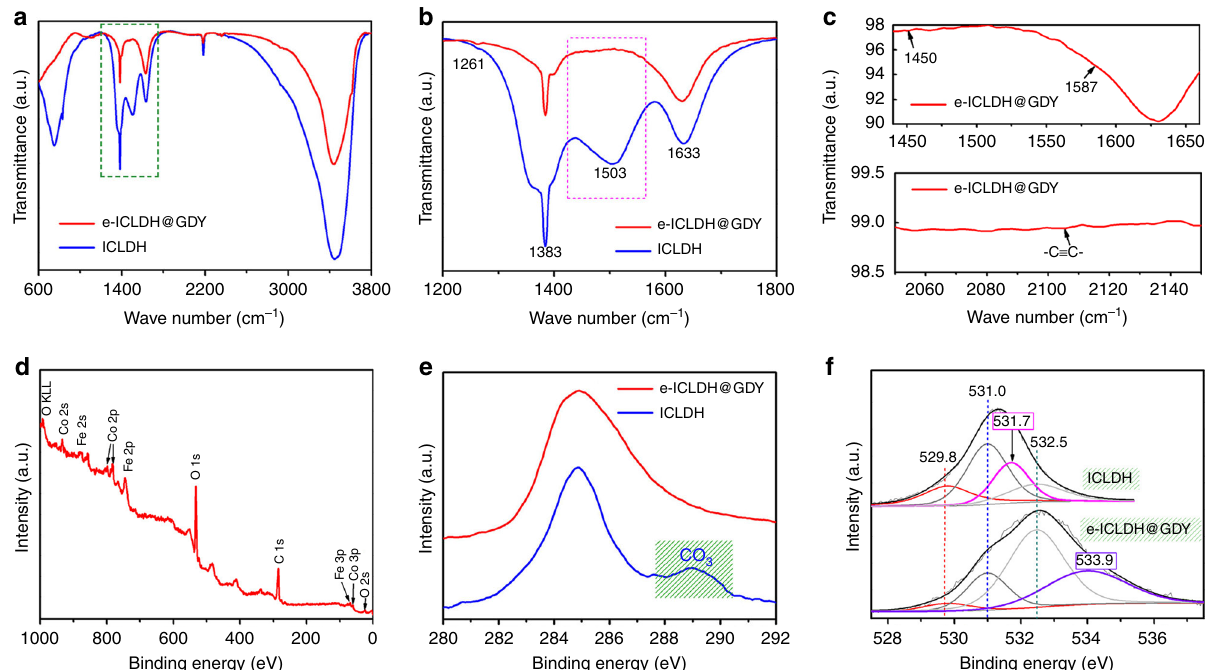
Fig. 4 Structural characterization of electrocatalysts. a FTIR spectra of the e-ICLDH@GDY/NF (red line) and pristine ICLDH/NF (blue line) structures. b Enlarged image of the selected area of the FTIR spectrum in a . c Selective enlargement of the FTIR spectra of e-ICLDH@GDY/NF. d XPS survey spectrum of e-ICLDH@GDY/NF. e , f Core-level XPS spectra of the e C 1s and f O 1s binding energies of the e-ICLDH@GDY/NF and pristine